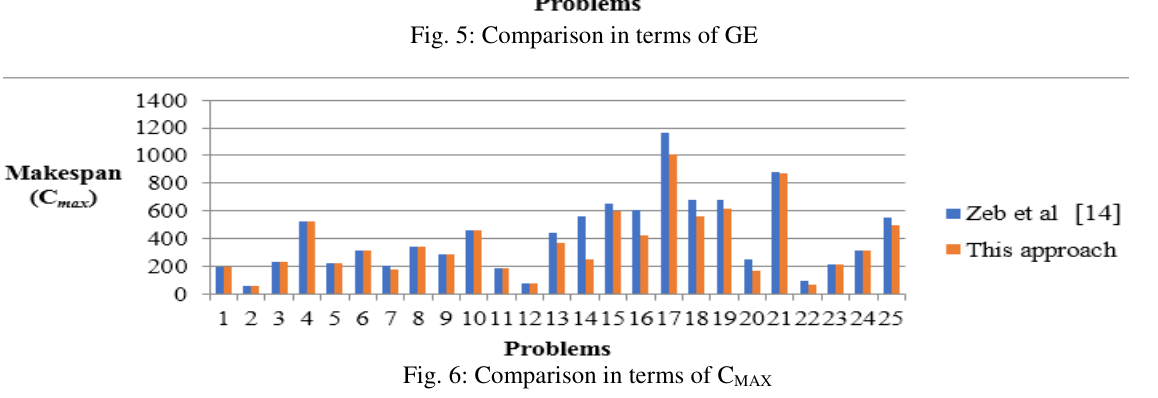
Fig. 5: Comparison in terms of GE